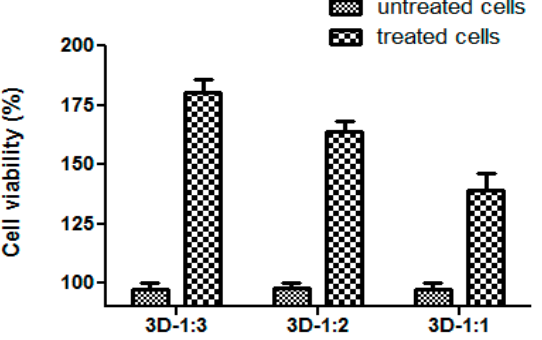
Figure 6. The percentage of viable cells grown in the presence of the obtained variants of composites as compared with their viability in standard conditions.